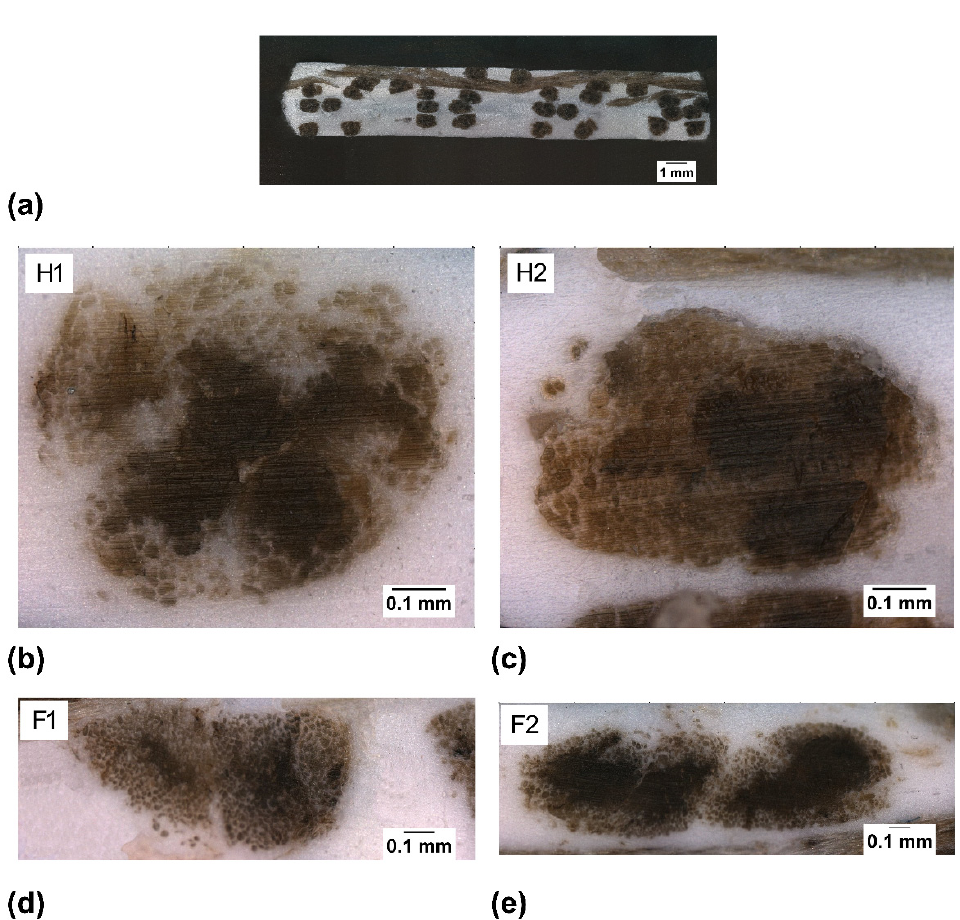
Figure 4. ( a ) Typical cross section of H 1 sample, ( b ) 10 × image magnification of typical yarn of H1, ( c ) H2, ( d ) F1 and ( e ) F2 samples.